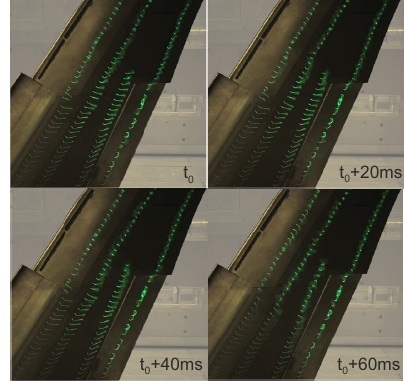
Figure 10. Progression of separation on the inboard